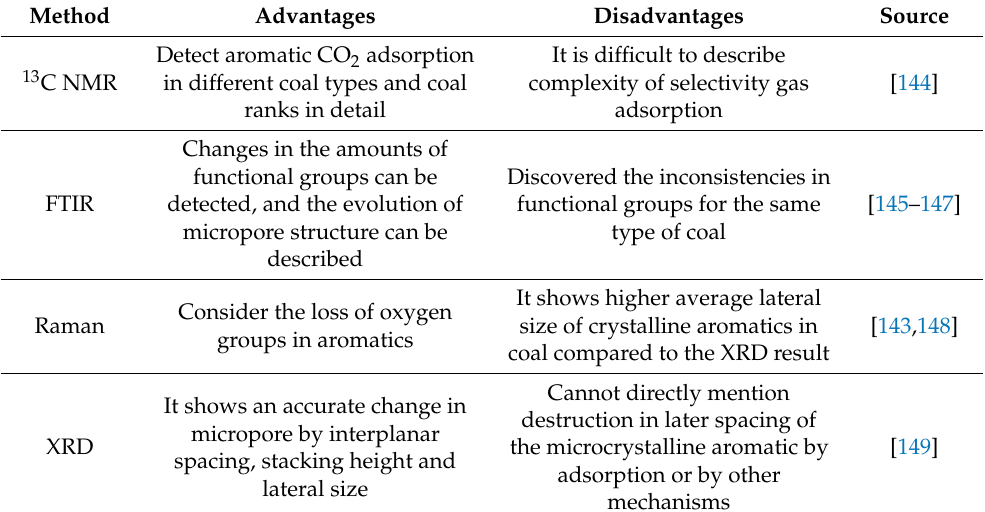
Table 2. Advantages and disadvantages of different techniques for evaluating gas adsorption in the chemical structures of coal. Method Advantages Disadvantages